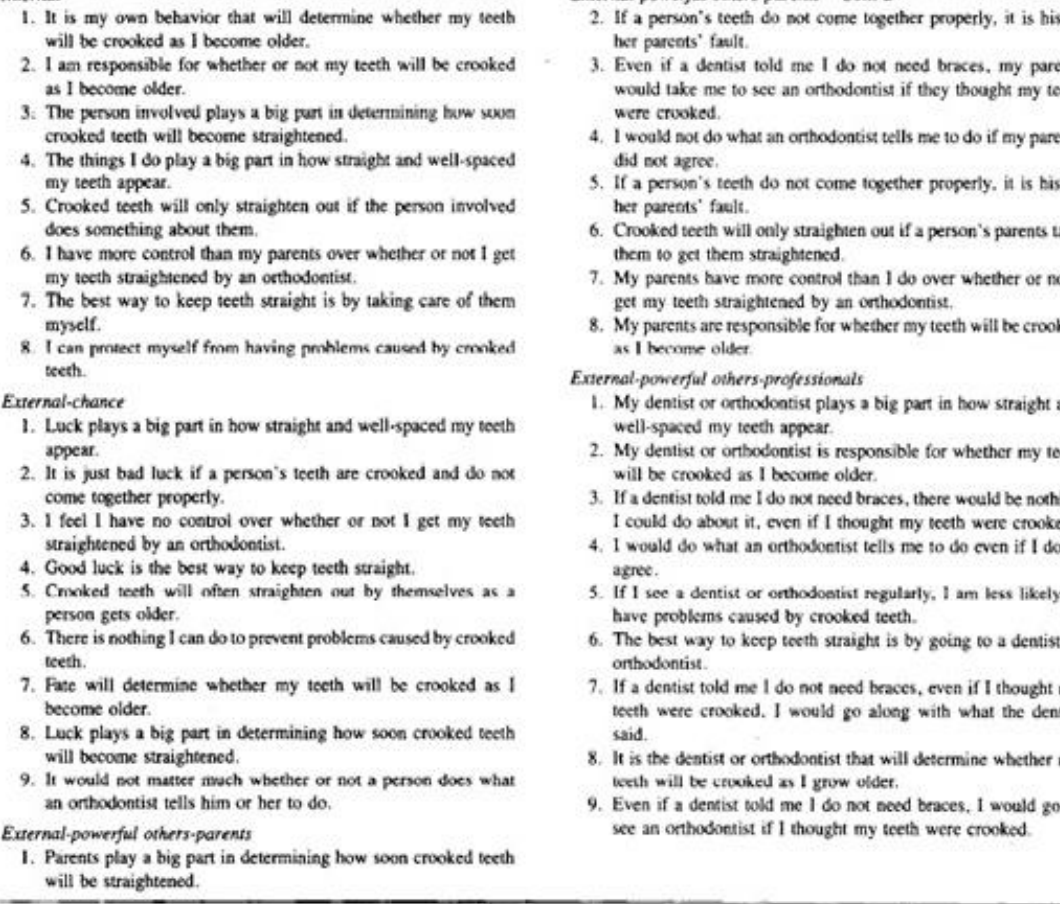
Figure 1: Orthodontic Locus of Control Scale (OLOCS) (26) questionnaire Statistical